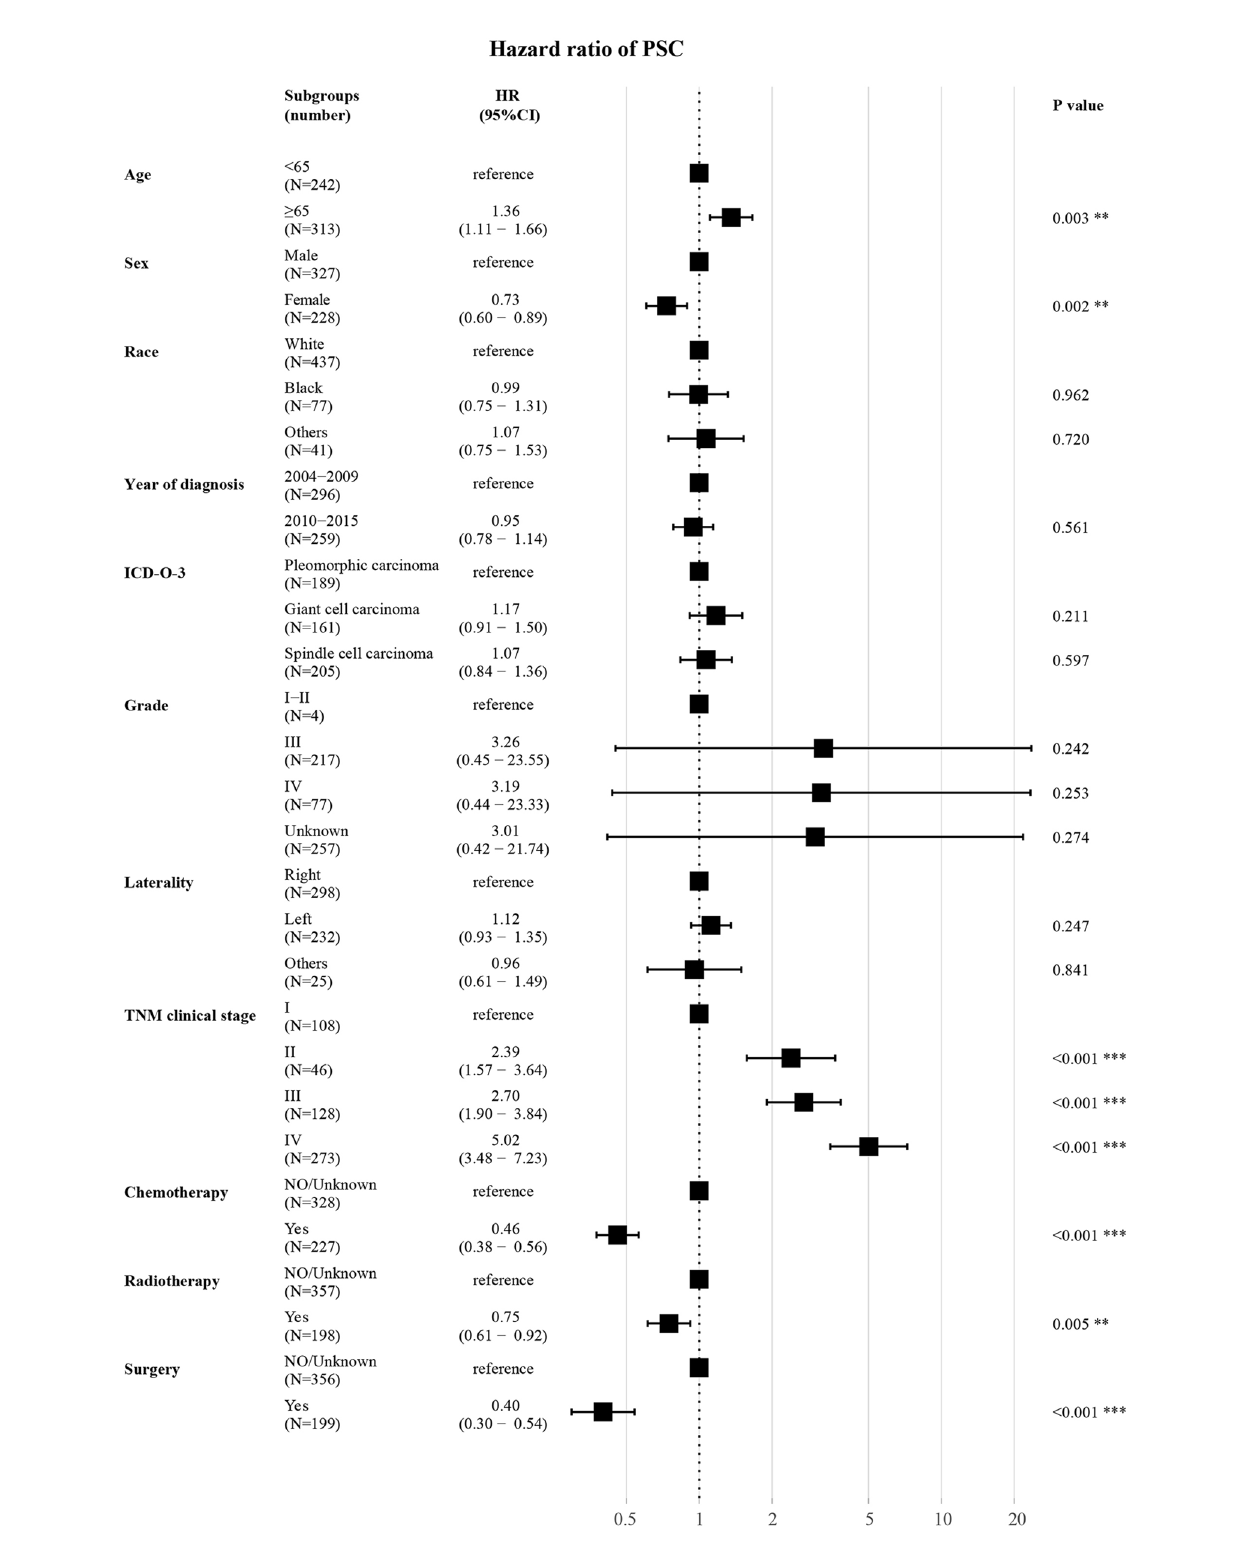
FIGURE 5 | Forest plot for multivariate analysis of the effect of different variables. HR, hazard ratio; CI, con fi dence interval; ICD-O-3, International Classi fi cation of Disease for Oncology, 3 rd Edition; TNM clinical stage, tumor – node – metastasis clinical stage. **P < 0.01; ***P <